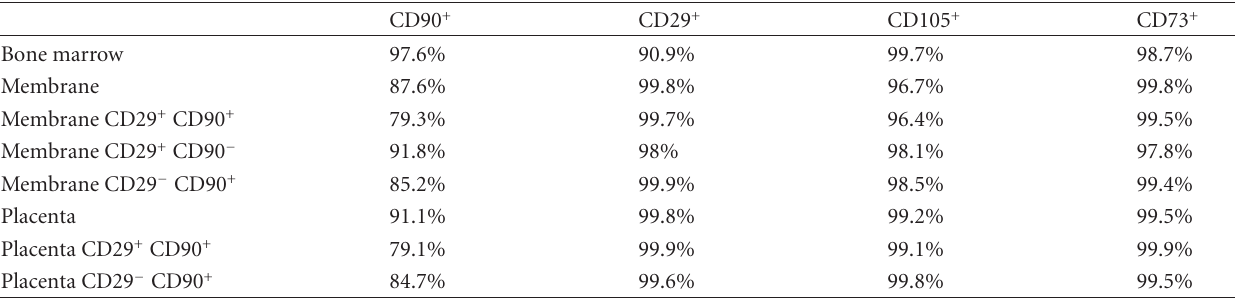
Table 1: Proportion of cell expressing MSCs specific markers. After 4 passages, every cell sorted subtype and bone marrow MSCs were stained for CD45, CD34, CD90, CD29, CD105, and CD73. 99% of the cells were CD34 and CD45 negative and more than 80% positive for the MSCs